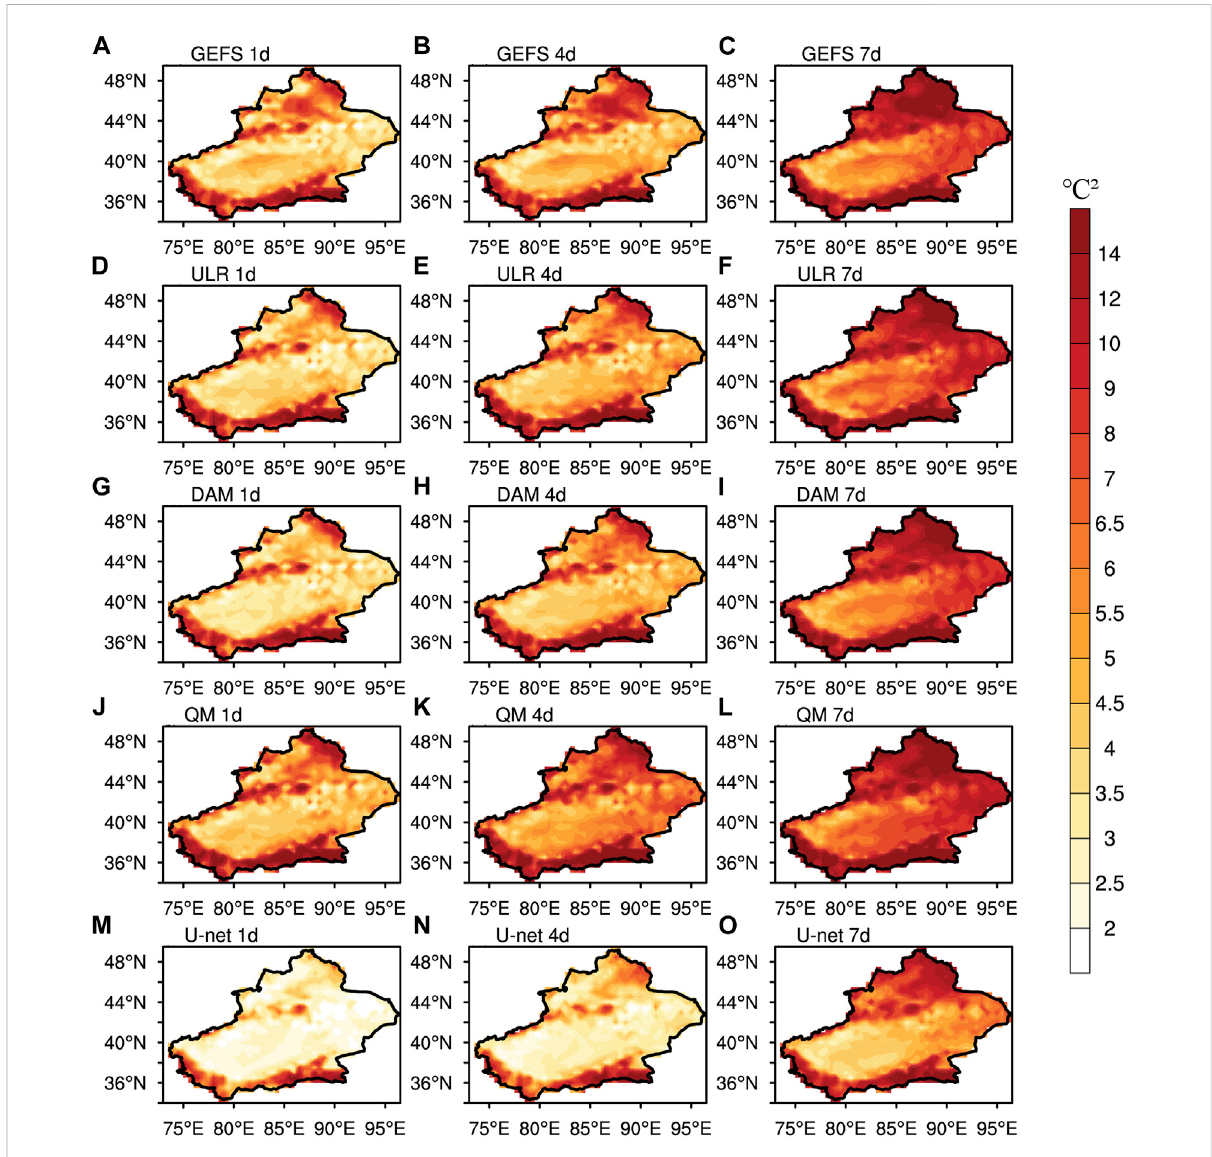
FIGURE 12 Spatial distributions of Sequence ( ℃ 2 ) with lead times of 1, 4, and 7 days derived from the MSE decomposition of GEFS (A – C) , ULR (D – F) , the DAM (G – I) , QM (J – L) and U-net (M – O)